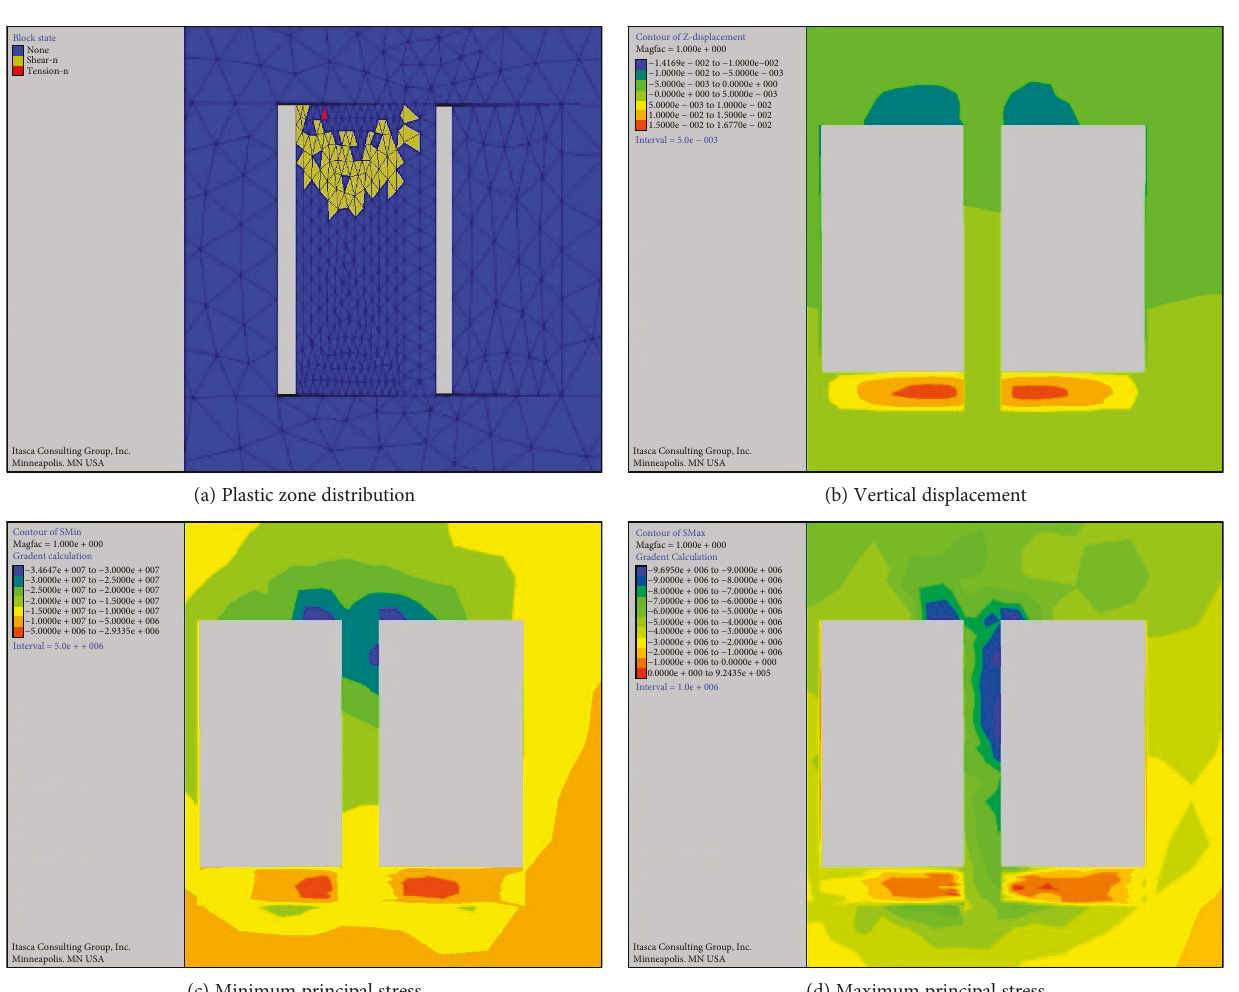
Figure 13: Scheme 1 mining